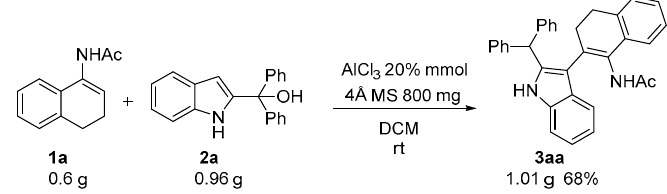
Figure 4. Scope of 2-indolemethanols with acyclic enamide 4.